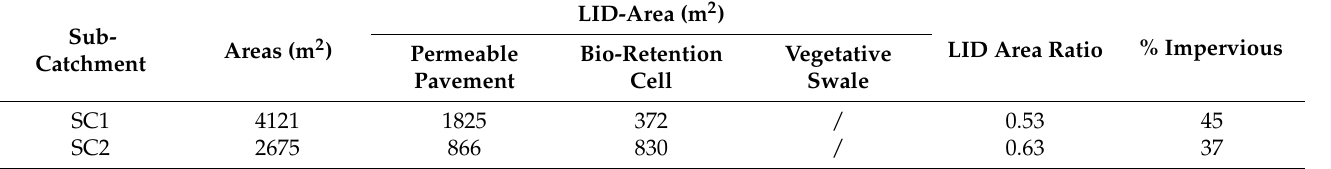
Table 4. LID settings in each sub-catchment